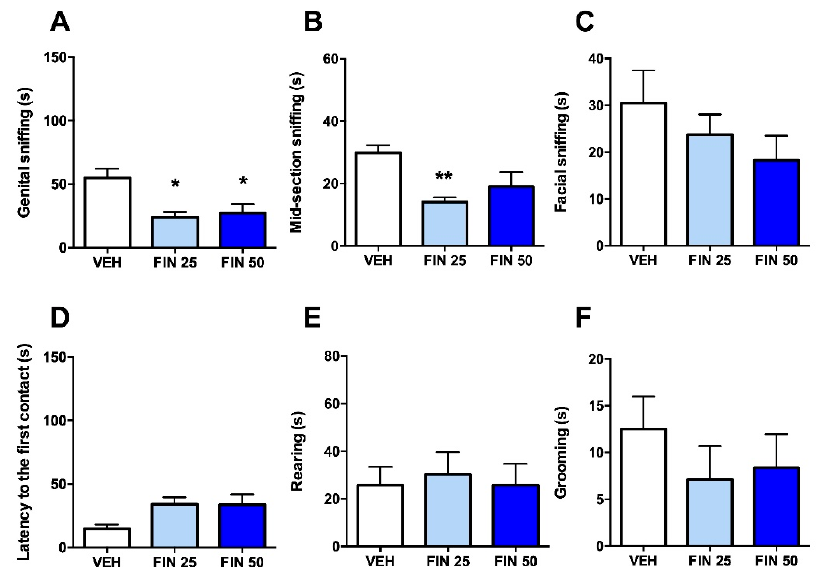
Figure 4. Finasteride (FIN) reduced social interaction with familiar social counterparts. FIN decreased the duration of the exploration of genital area ( A ) and mid-section ( B ), but not facial areas ( C ) of cage mates. Furthermore, FIN had no effect on the latency to the first social approach ( D ), duration of rearing behavior ( E ) and grooming; n = 7–8/group ( F ). * p < 0.05, ** p < 0.01 in comparison with rats treated with vehicle (VEH). Doses of FIN are indicated in mg/kg (IP).